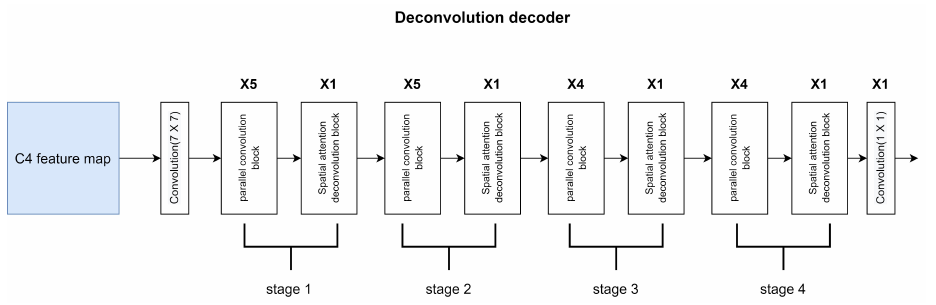
Figure 6. Deconvolution